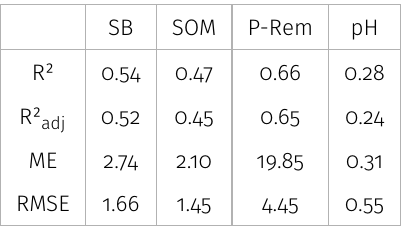
Table IV. Validation results of the maps generated for soil fertility attributes from samples collected at Lavras, Minas Gerais,